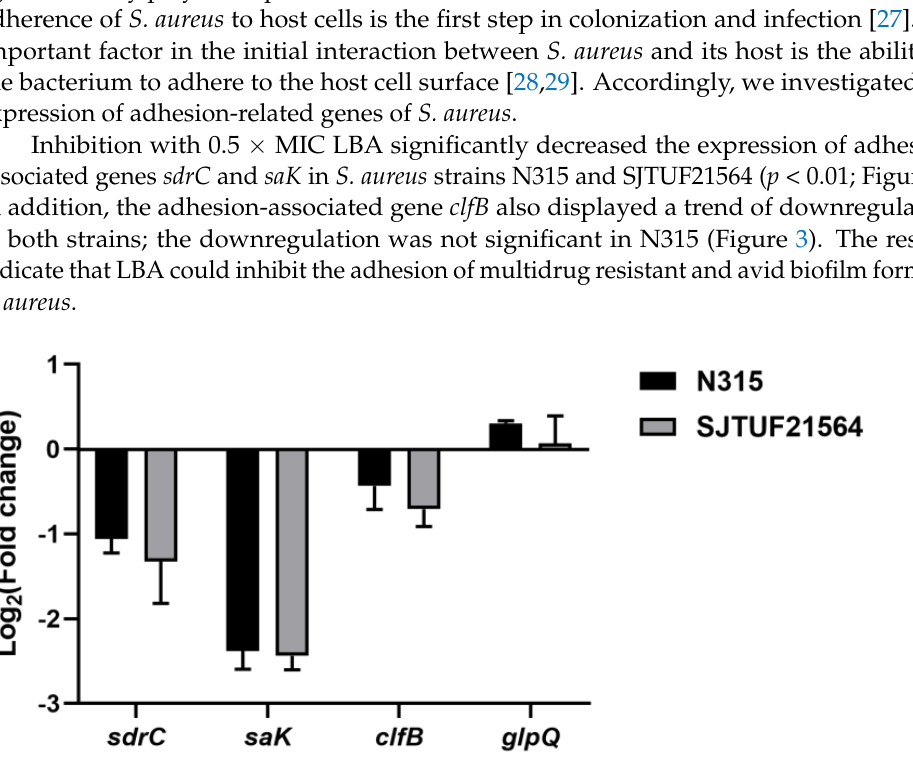
Figure 3. Expression of adhesion genes and glpQ in S. aureus after treatment with 0.5 × MIC LBA by RT − qPCR.